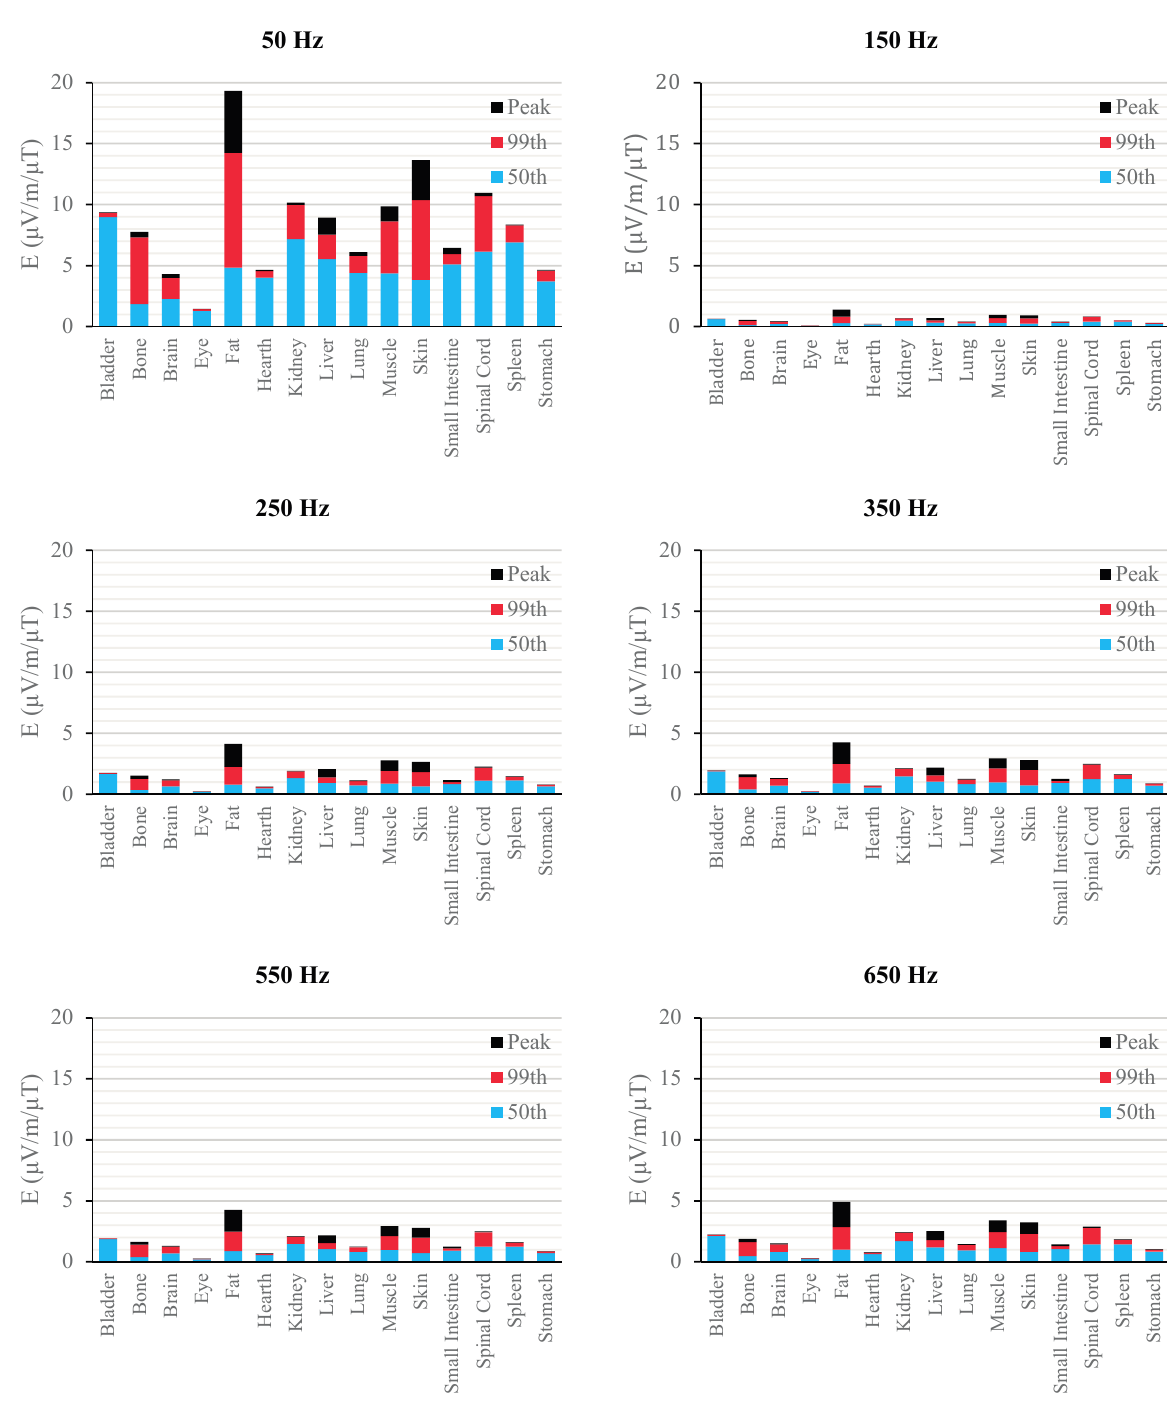
Figure 3. E ( μ V/m) per μ T of 50 Hz B peak induced in foetal tissues at 3 mGA for all the harmonic frequencies considering the standard EN 50160 for the HV power supply networks. The bars indicate the E 50th (blue), the E 99th (red) percentiles and the E peak (black) of each